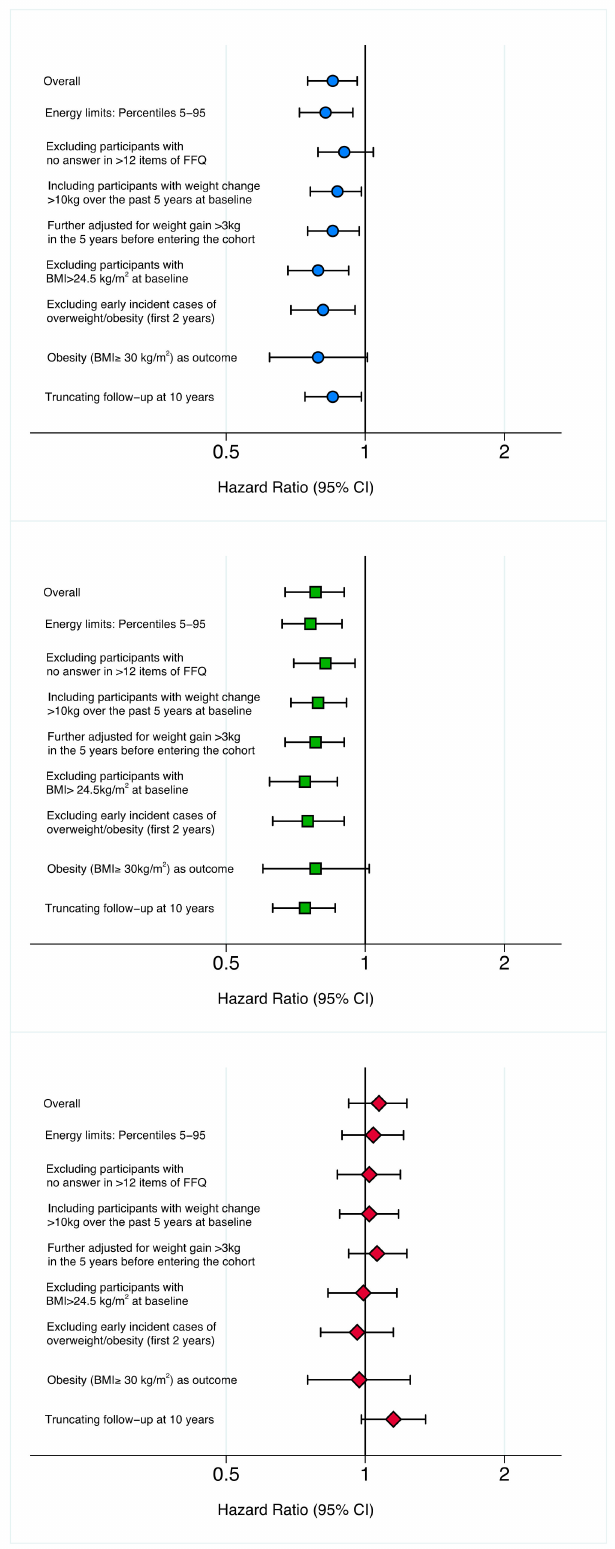
Figure 3. Sensitivity Analyses (results under di ff erent scenarios). Hazard Ratios (95% CI) of incident overweight / obesity for extreme quintiles (Q5 vs. Q1) of adherence to the overall, healthful and unhealthful provegetarian food